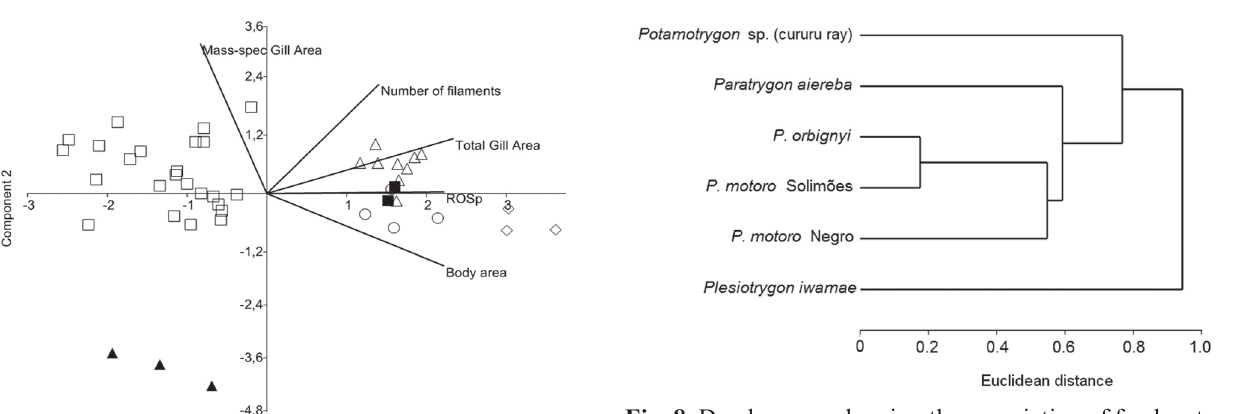
Fig. 8 . Dendrogram showing the association of freshwater stingrays based on the gill morphometry of the